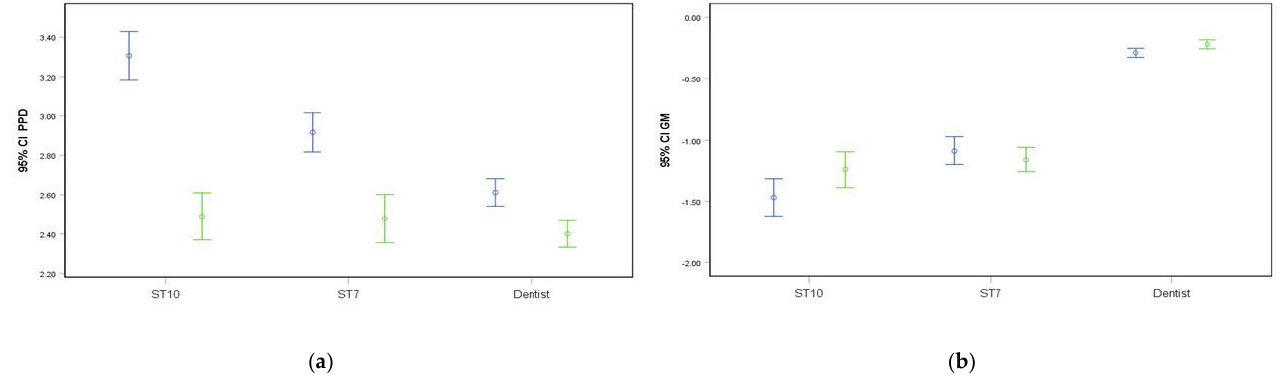
Figure 3. ( a ) PPD for manual (MP; blue) or electronic probing (EP; green) differentiated by level of examiner ’ s experience (dentist, 10th (ST10) or 7th semester students (ST7)) with 95% confidence intervals ( b ) GM for manual (MP; blue) or electronic probing (EP; green) differentiated by level of examiner’s experience (dentist, 10th (ST10) or 7th semester students (ST7)) with 95% confidence intervals.